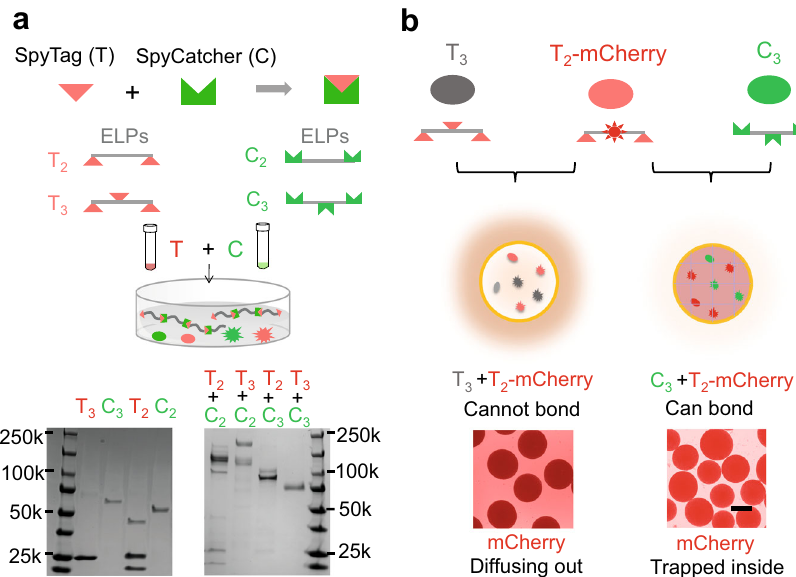
Fig. 2 Formation of living sIPN. a Formation of protein complexes by elastin-like polypeptides (ELPs) monomers containing SpyTags and SpyCatchers released from engineered bacteria (top: schematic; bottom: experimental data). ELPs decorated with multiple SpyTags or SpyCatchers released by the co- cultured bacteria reacted to form covalent bonds in the supernatant. Overnight culture of bacteria expressing proteins with multiple SpyTags (T, MC(T 2 - mCherry) or MC(T 3 )) and bacteria expressing proteins with multiple SpyCatchers (C, MC(C 2 ) or MC(C 3 )) were co-cultured in M9 medium containing 1 mM IPTG. After 24 h, the supernatant was harvested, puri fi ed by His-tag af fi nity resins and tested by SDS – PAGE. Compared with the monomers (left), all four combinations between SpyTag and SpyCatcher generated protein complexes with higher molecular weight, indicating reaction occurred between monomers. The experiment was repeated more than three times independently with similar results. b Stronger mCherry signal inside living sIPN capsules containing compatible monomers released by engineered bacteria (top: schematic; bottom: experimental data). MC(T 2 -mCherry) and MC (C 3 ) were mixed, pelleted and encapsulated with chitosan. As a control, MC(C 3 ) was replaced with MC(T 3 ). The capsules were cultured in M9 medium containing 1 mM IPTG. Due to the sIPN formation, the mCherry protein was immobilized inside the capsules, leading to strong fl uorescence of the capsules but little in the surrounding medium (right). In the control group, the mCherry protein was not trapped due to the lack of sIPN formation, and diffused out to the surrounding medium (left). The scale bar is 200 μ m and the photos were taken at 24 h. The experiment was repeated more than three times independently with similar